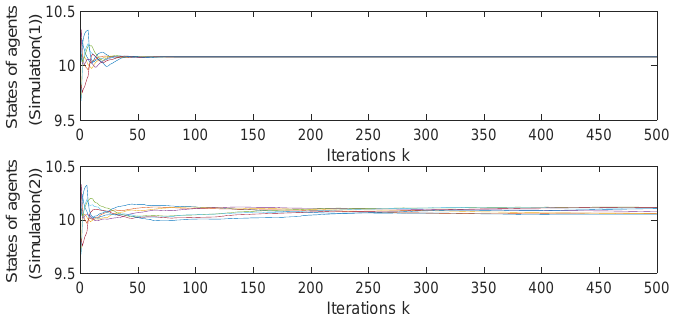
Figure 5. The state change curve of agents in the simulation (1) and the simulation